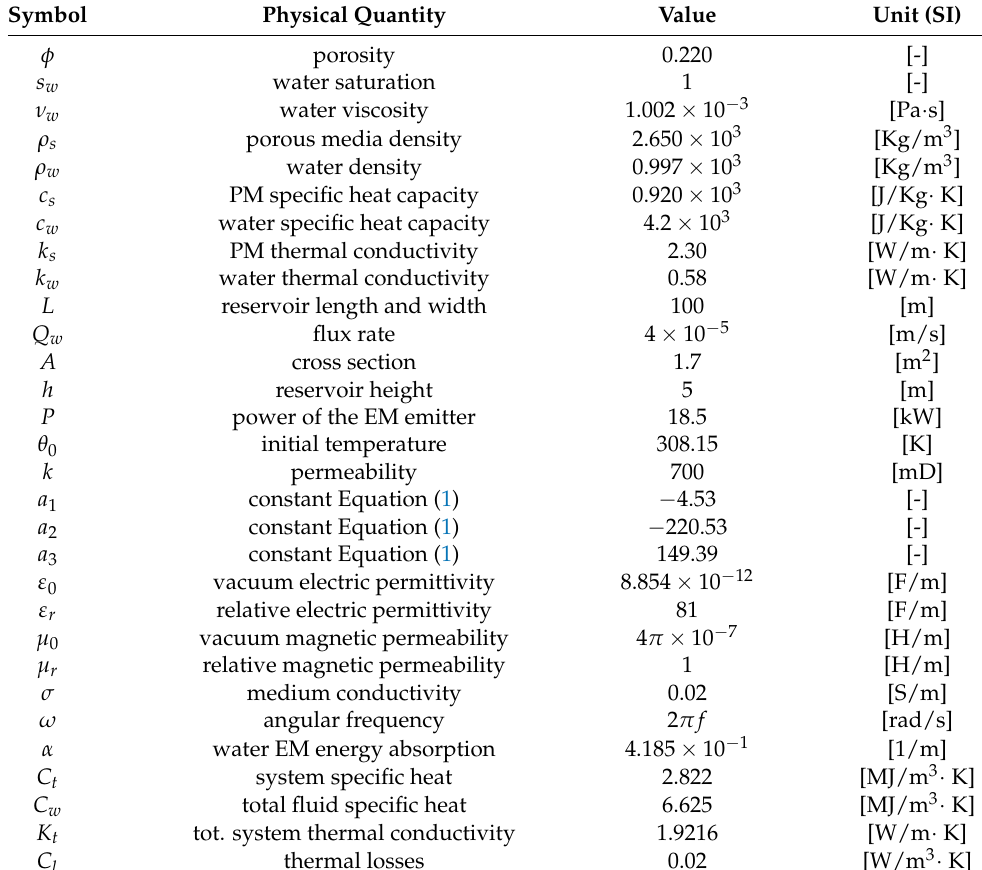
Table 1. Physical parameters used in